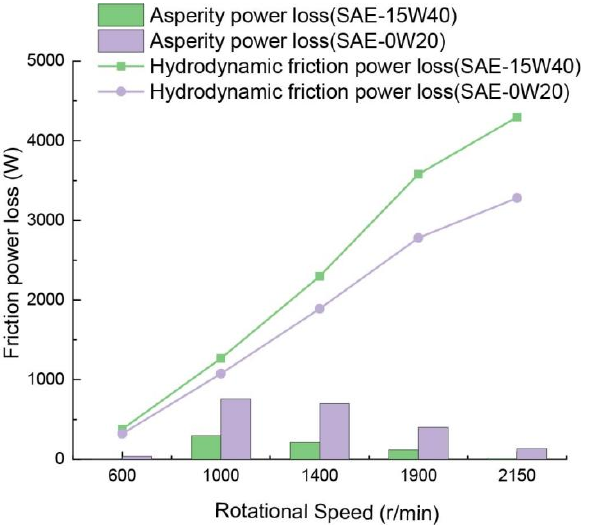
Figure 11. Comparison of total friction power consumption of main bearing with normal viscosity oil and low viscosity oil under typical working conditions.